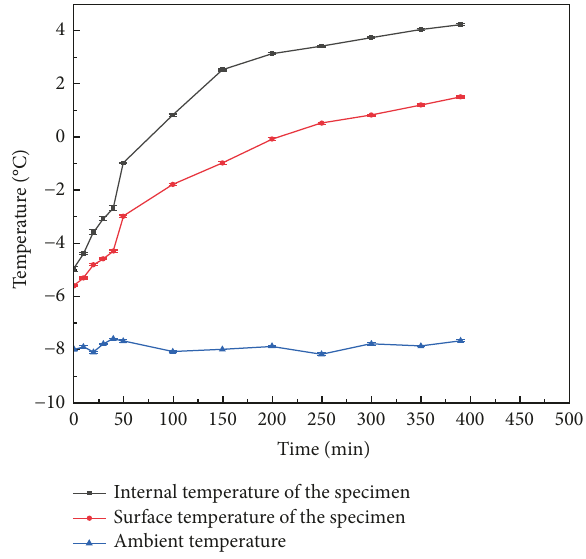
Figure 18: Deicing effect of 0.5% carbon fiber +30% graphite rutting